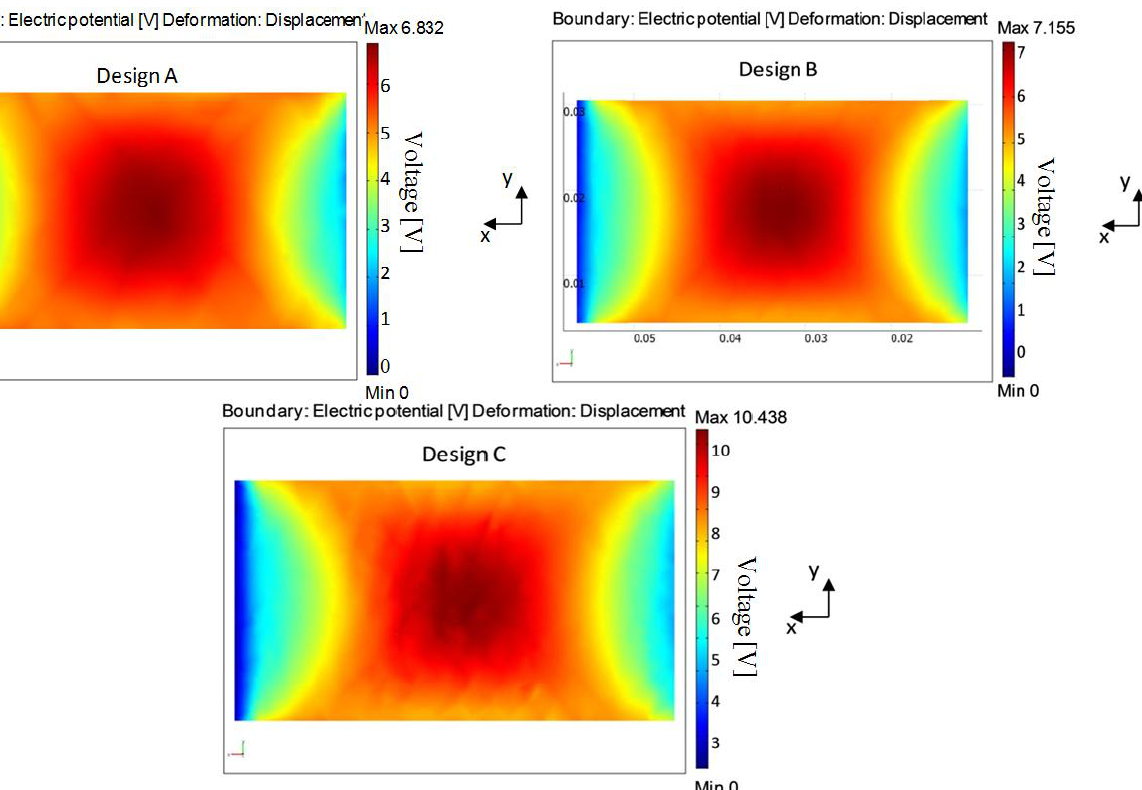
Figure 17. Voltage distribution developed in the DPT transducer under the boundary conditions shown in Figure